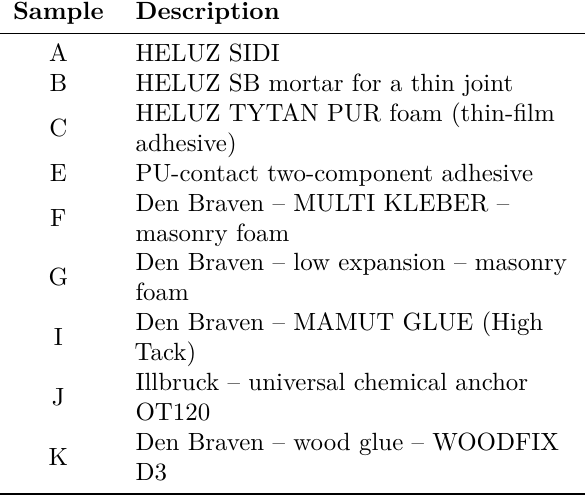
Table 1. List of used adhesives